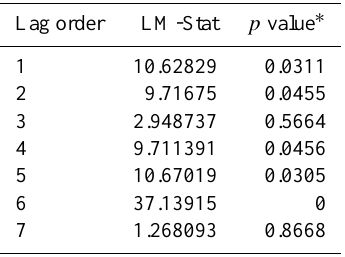
Table 10. VAR Residual Serial Correlation LM Tests component of Granger causality testing of relationship between second-difference CO 2 and SOI. Initial 2-lag model. Lag order